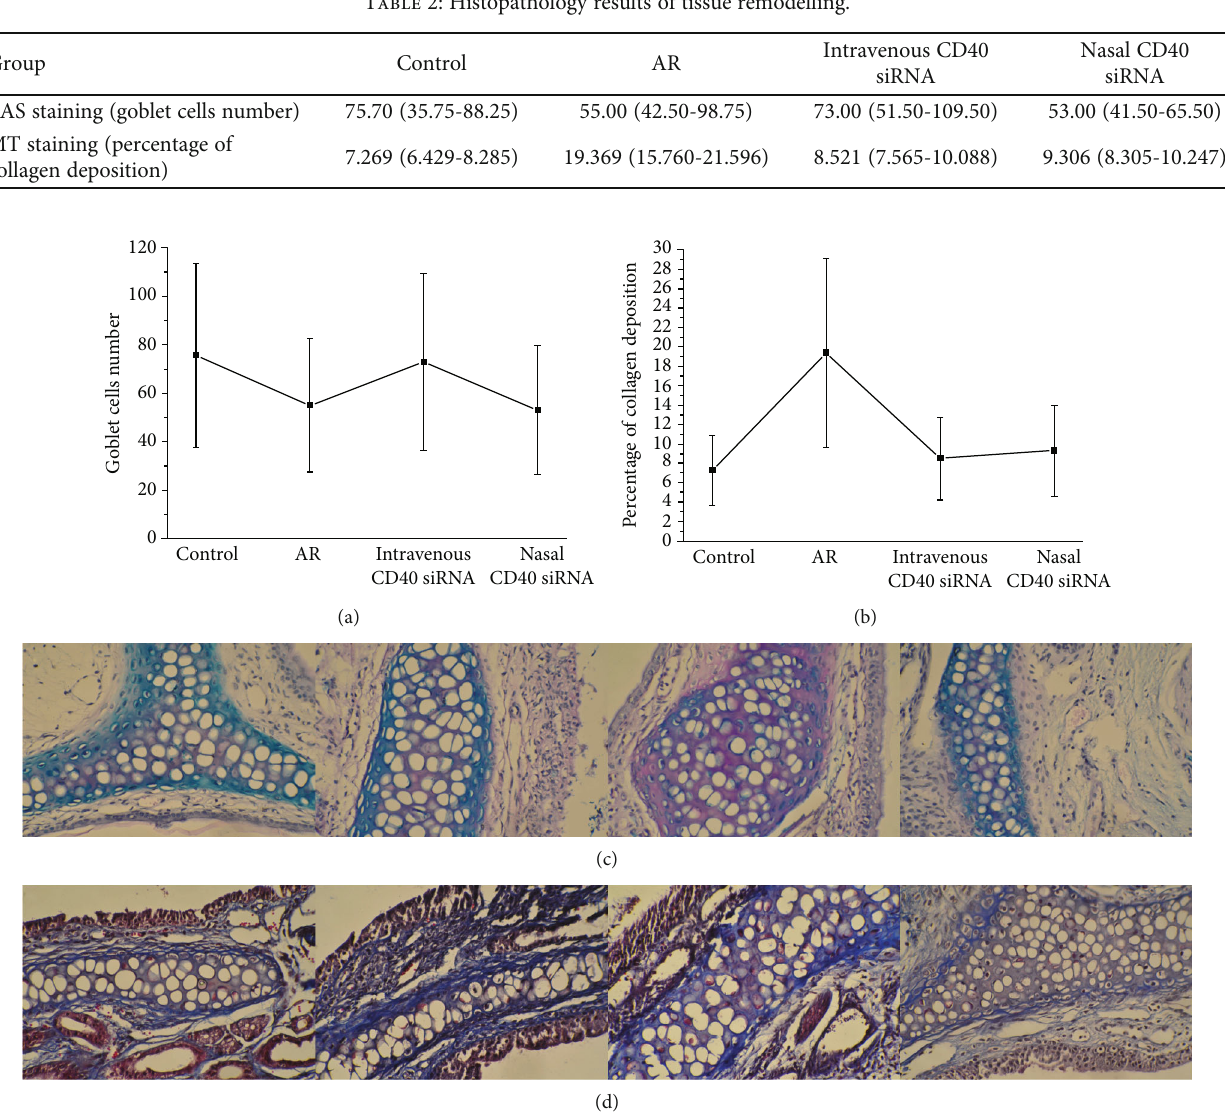
Figure 5: (a) Goblet cell numbers of control, AR, intravenous CD40 siRNA, and nasal CD40 siRNA groups were detected by PAS